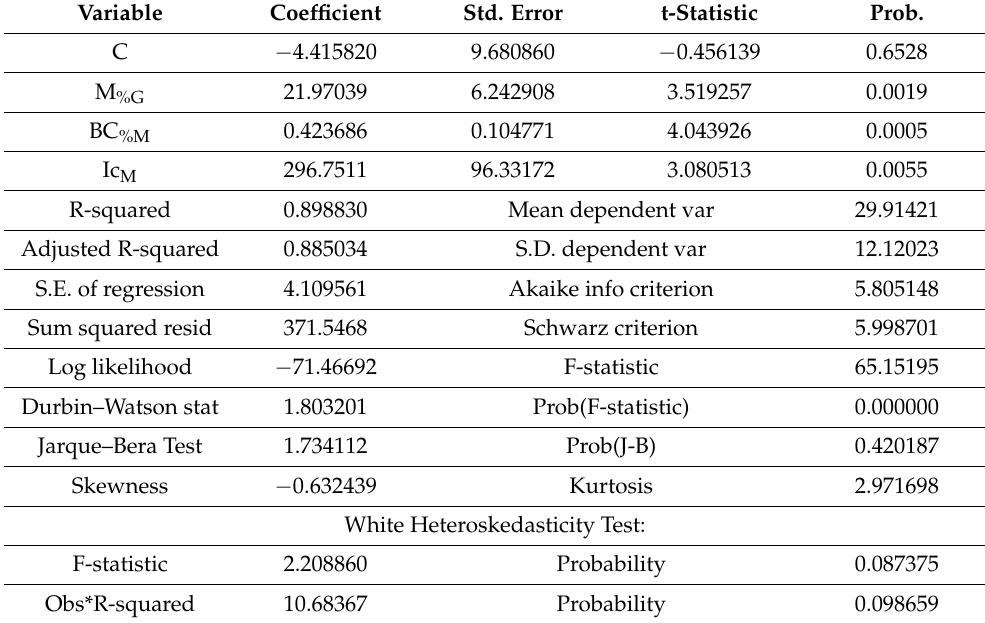
Table 9. S FDI_in(%GDP) model by M %G , BC %M and Ic M for